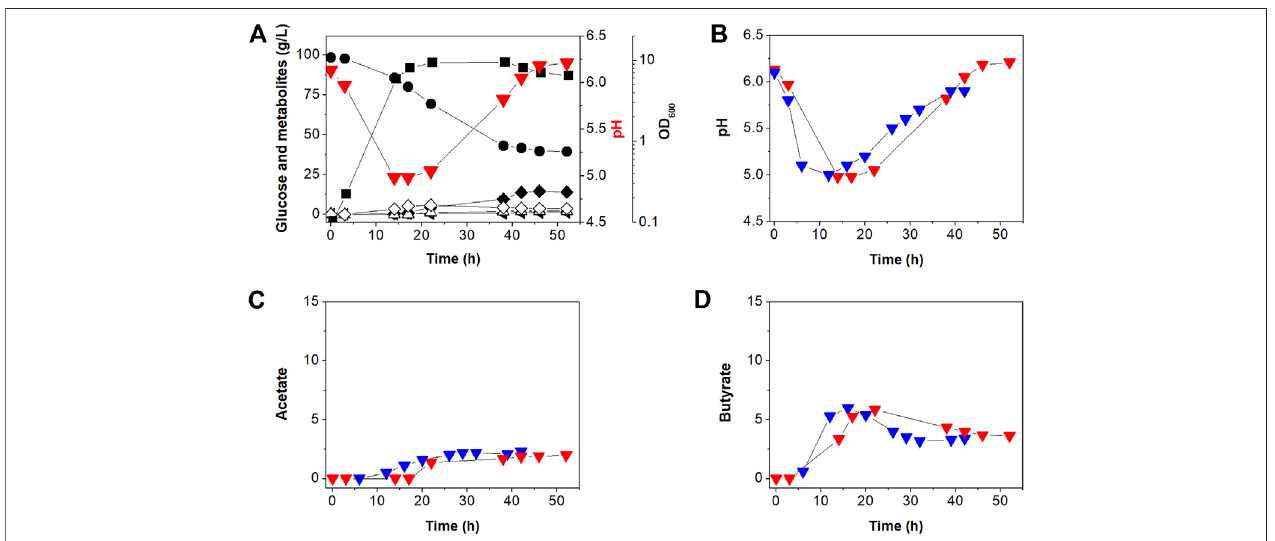
(cid:129) , glucose; ■ , cell density